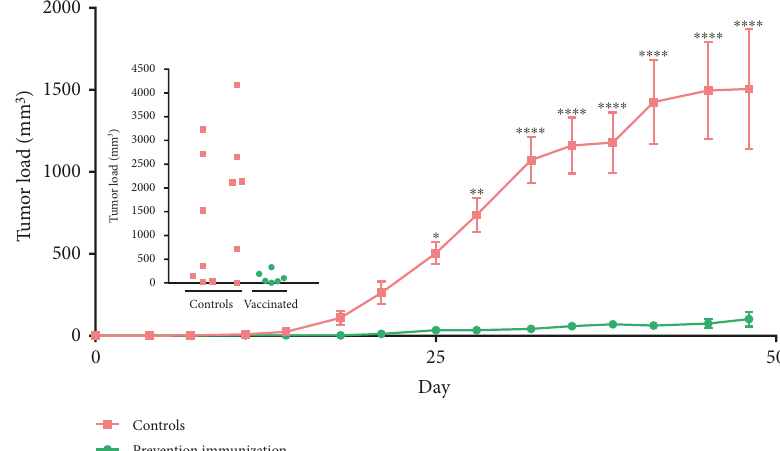
Figure 1: J-HER prevention of TUBO cell tumor development. Mice were immunized with HBSS in Montanide ISA-51 adjuvant (orange rectangles) or J-HER in adjuvant (green circles), which was repeated 14 days later, and one week later, immunized mice ( n = 7 ) and unimmunized mice ( n = 14 ) were challenged with 2.5 × 10 [7] TUBO cells in each of two sites. Tumor volume is presented with respect to day after tumor challenge. Inset shows total tumor size for individual mice at day 48, end of experiment. ( ∗ p < 0 05 ; ∗∗ p < 0 01 ; ∗∗∗ p < 0 001 ; ∗∗∗∗ p < 0 0001